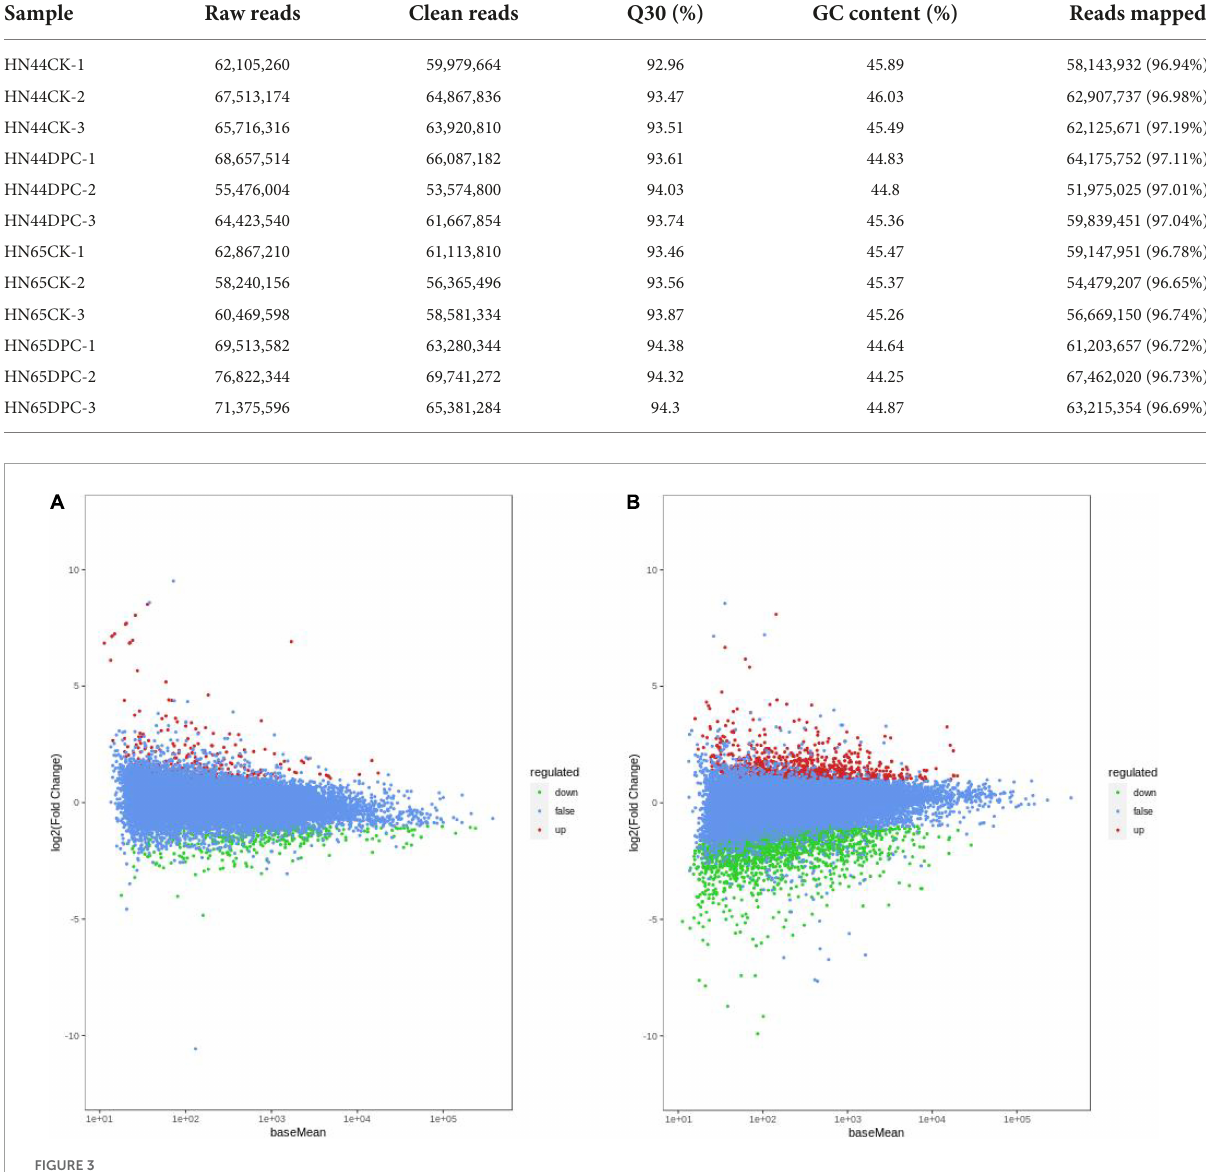
TABLE 1 Quality statistics of sequencing samples.